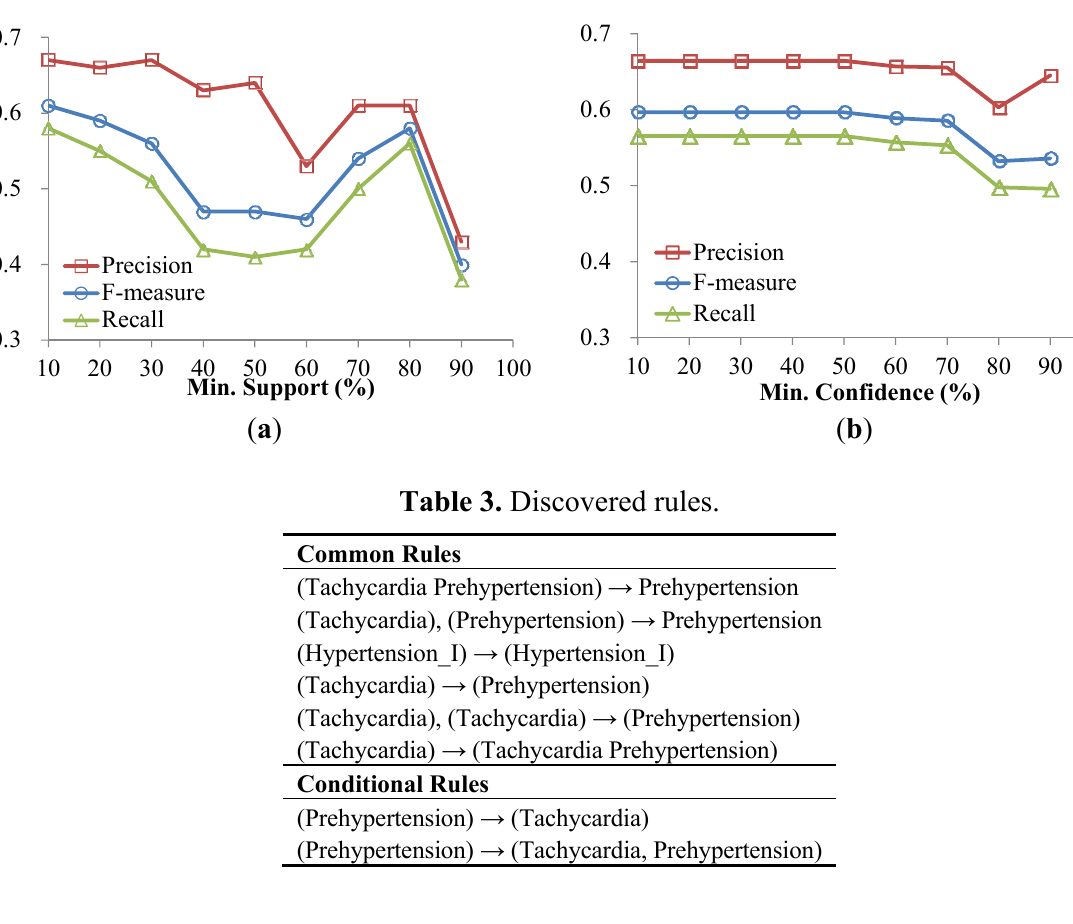
Figure 8. Precision, Recall and F-measure with varying min. support and min.